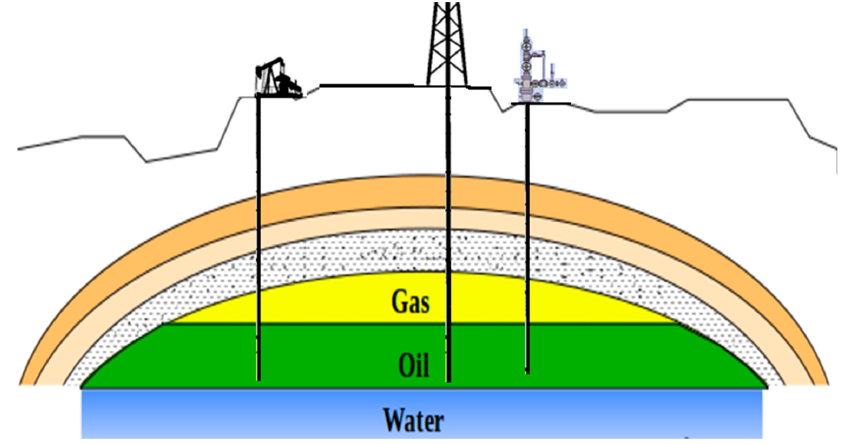
Figure 1. An example of an oil reservoir with a gas cap.